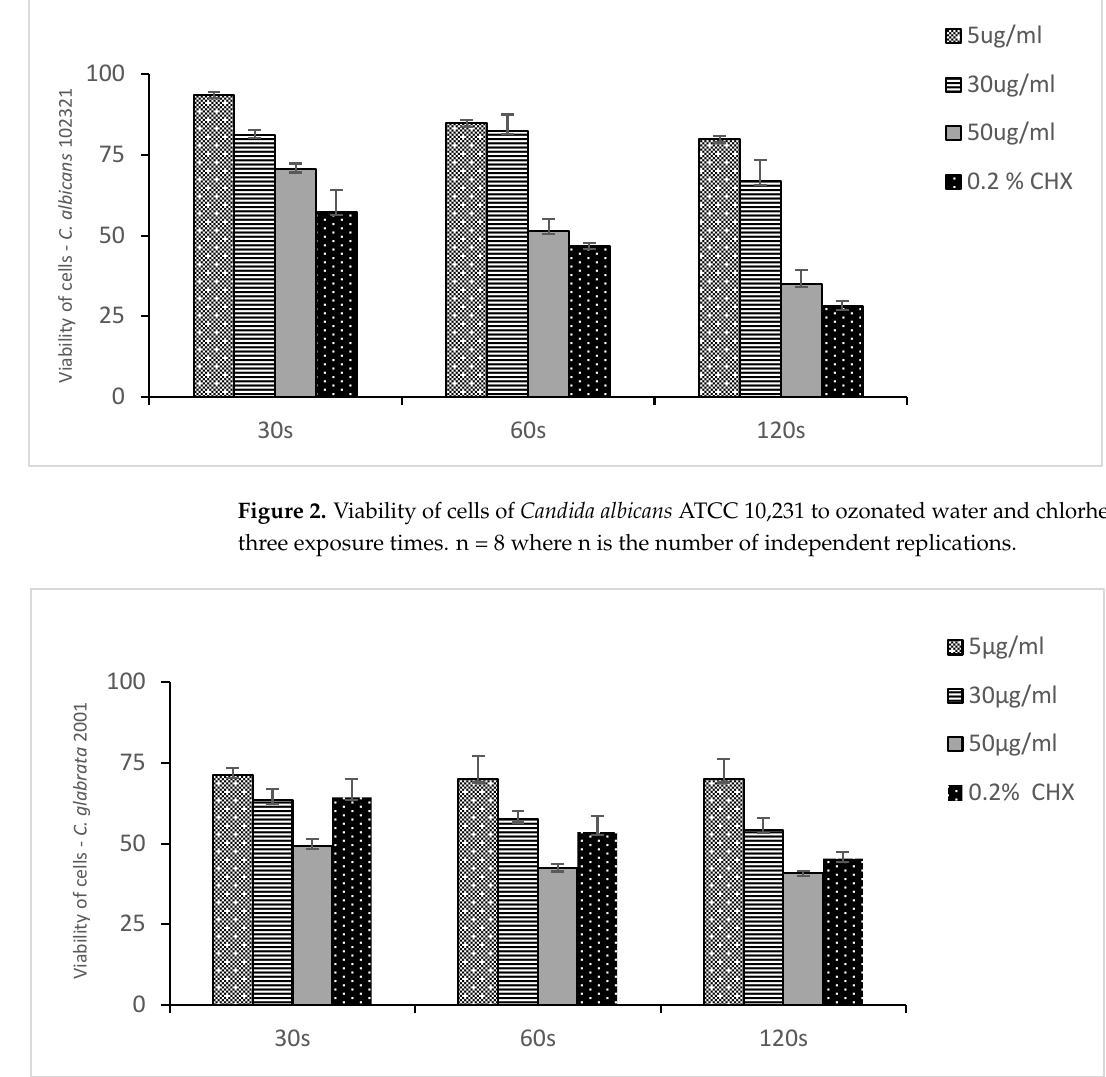
Figure 3. Viability of cells of Candida glabrata ATCC 2001 to ozonated water and chlorhexidine in three exposure times. n = 8.